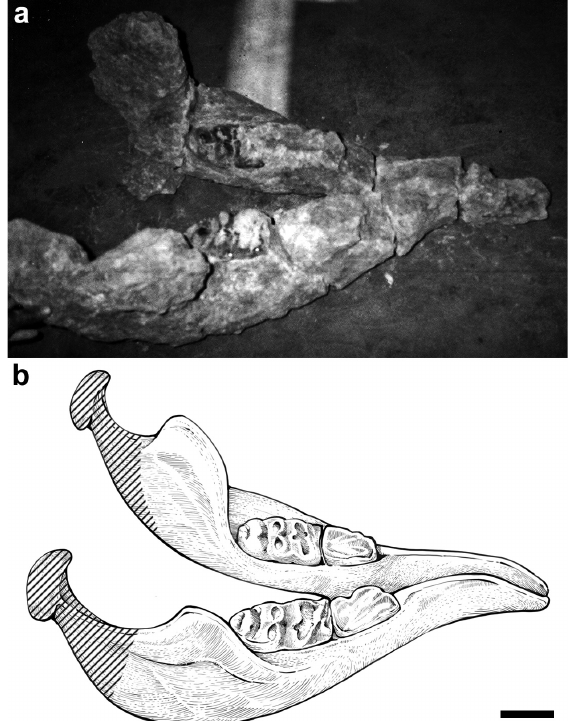
Figure 1 - The original record of “Yanghecun specimen”. Note the longirostrine symphysis fragmented in two pieces (on the right). ( a ) Original photo of the complete specimen, an almost complete lower jaw; ( b ) Reconstructed sketch of Yanghecun specimen based on original picture in ( a ) by Pablo Lara. The region of the condyles (hachured area) was reconstructed based on Mammut americanum and may not correspond anatomically to Sinomammut . Scale bar: 10